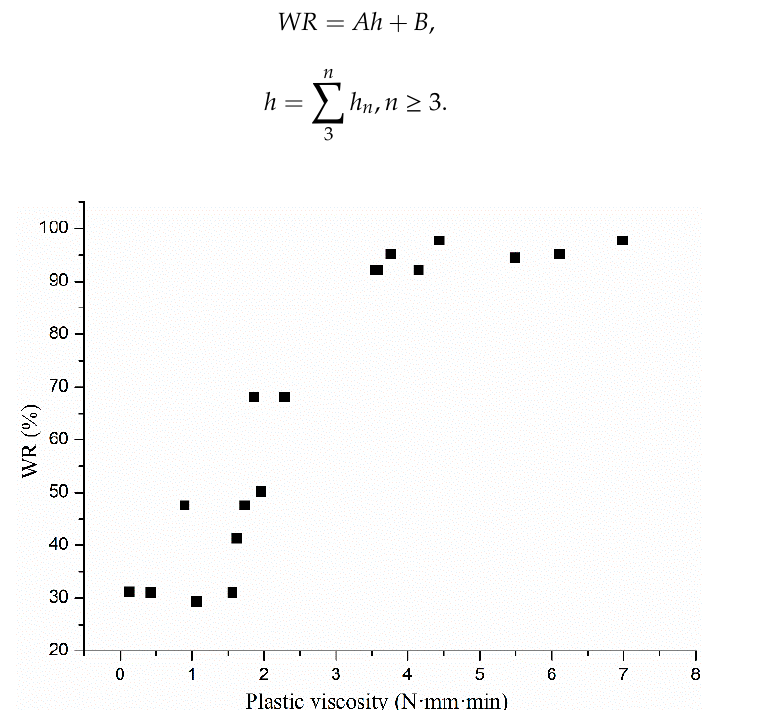
Figure 6. Relationship between plastic viscosity and water retention of multi-group cement mortar.